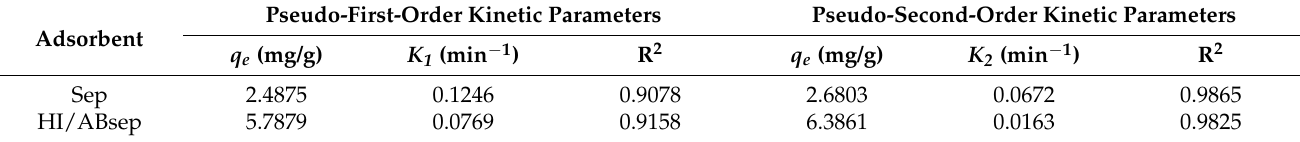
Table 1. Kinetic parameters of adsorption on Sb